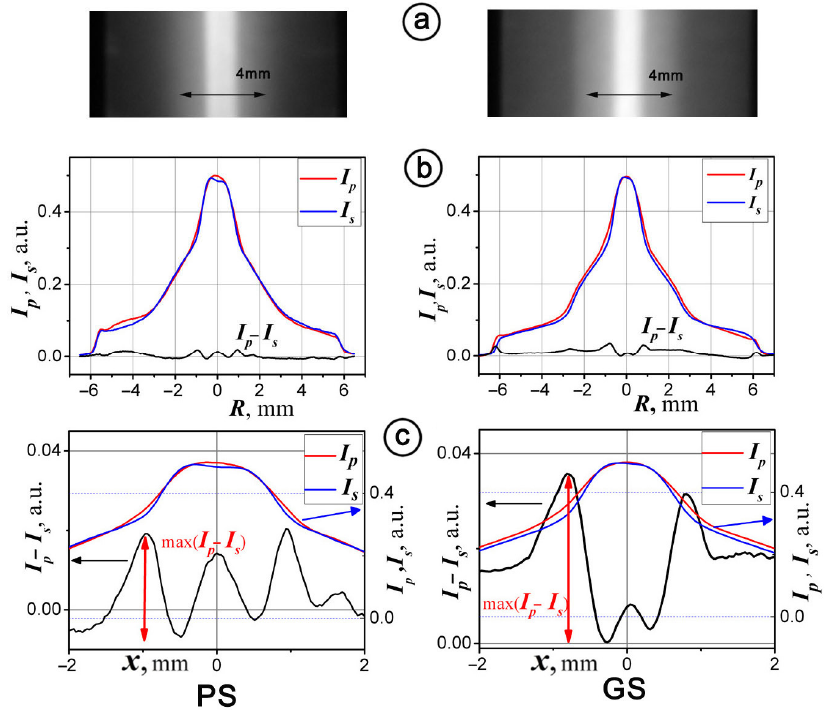
Figure 3. (PS) The PS preform data and (GS) the GS preform data: ( a ) image of the heated region of the preform; ( b ) measured intensity of the thermal radiation (in the visible range) for two polarizations against the x ‐ coordinate, where Ip(x) is marked by a red line and Is(x) is marked by a blue line; ( c ) center region of the preform ( − 2 mm < x < 2 mm).